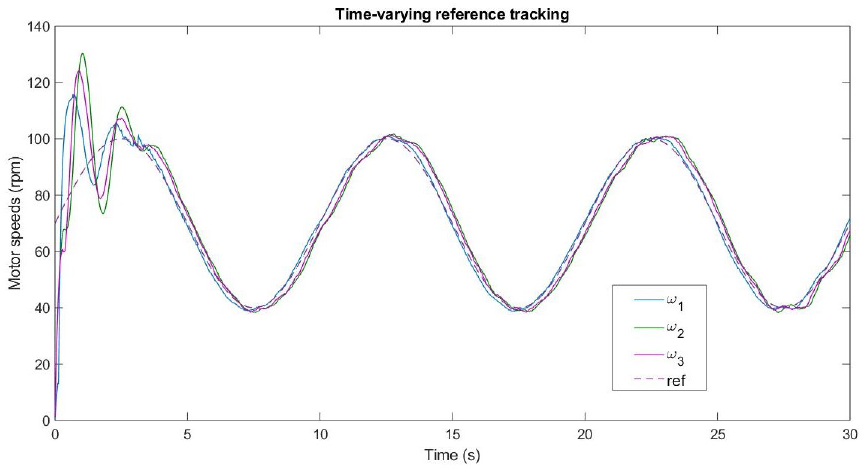
Figure 7. Experimental speed tracking using a sinusoidal reference.